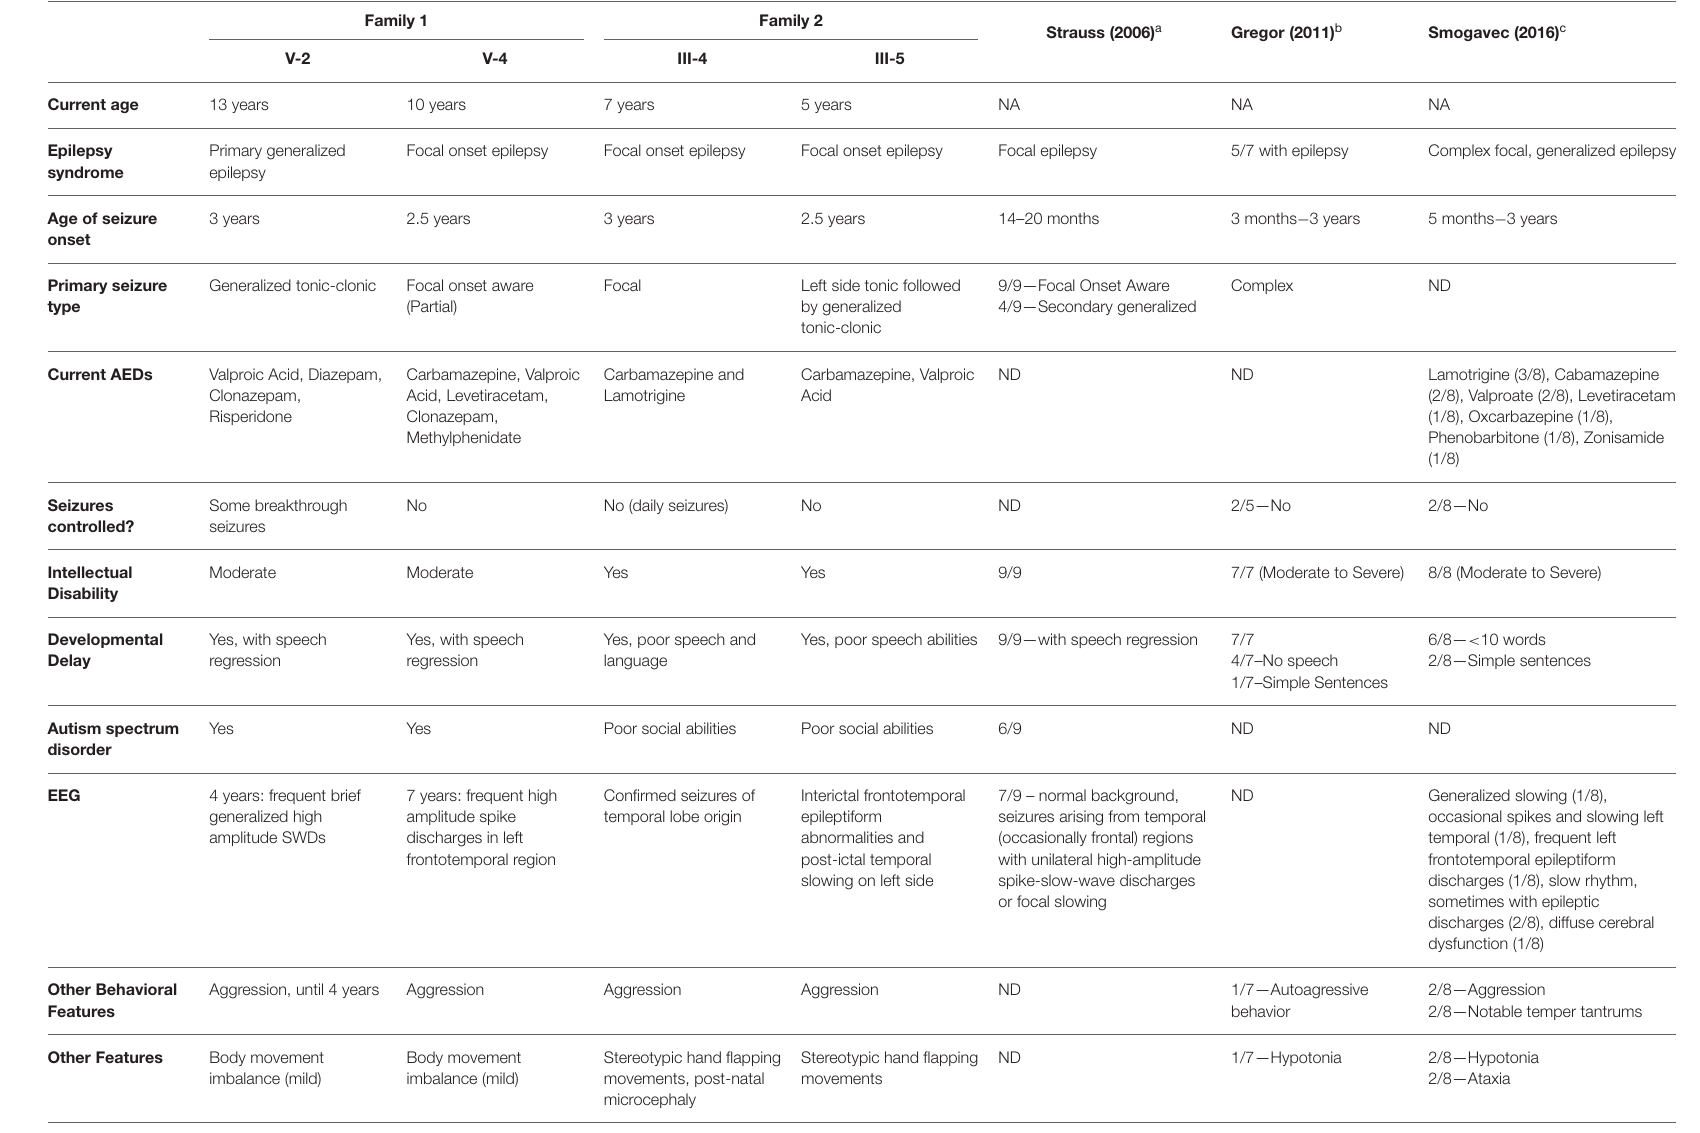
TABLE 1 | Clinical presentation of affected siblings and comparison to previously reported